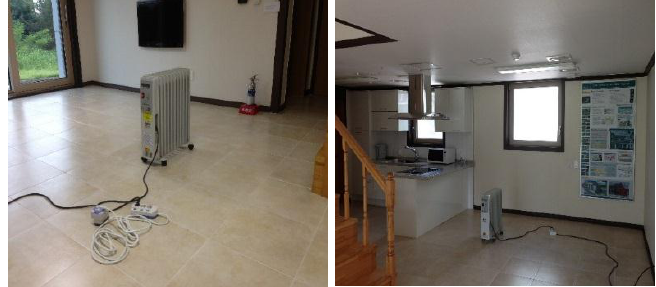
Figure 5. Two electric heaters on the first floor inside the demonstration house to simulate internal heat